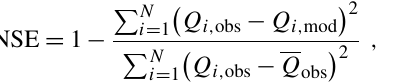
tion. The NSE is defined